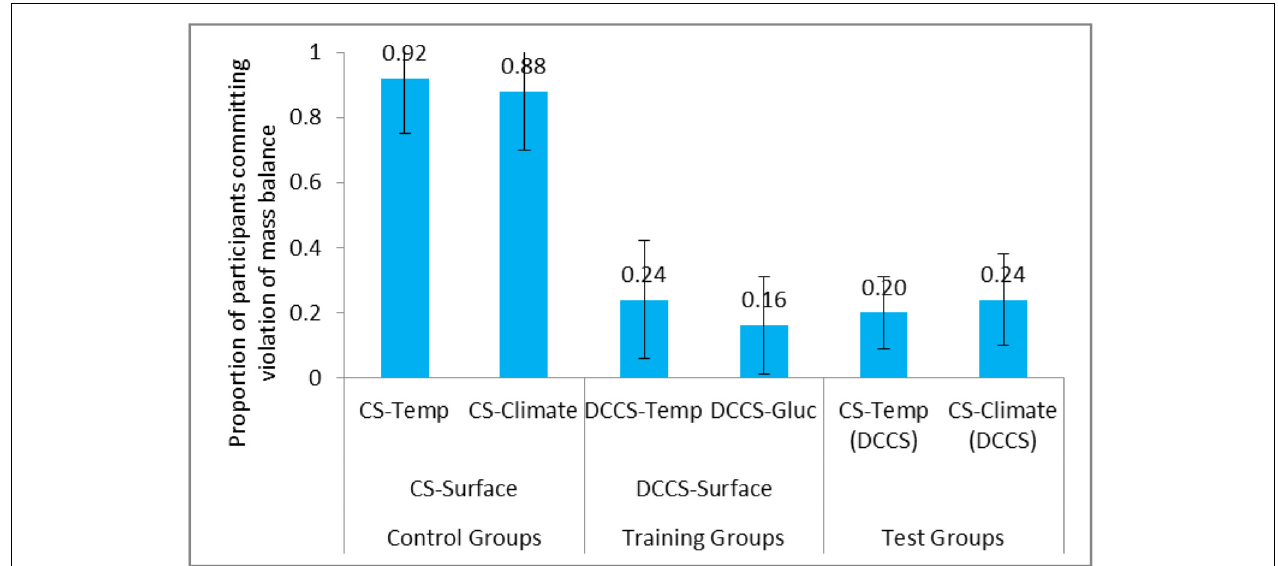
FIGURE 8 | Proportion of participants committing violation of mass balance in surface conditions. The CS-Temp (DCCS) and CS-Climate (DCCS) refer to CS tasks following the DCCS performance in the DCCS-Surface condition. The error bars represent 95% confidence interval around the point estimate.